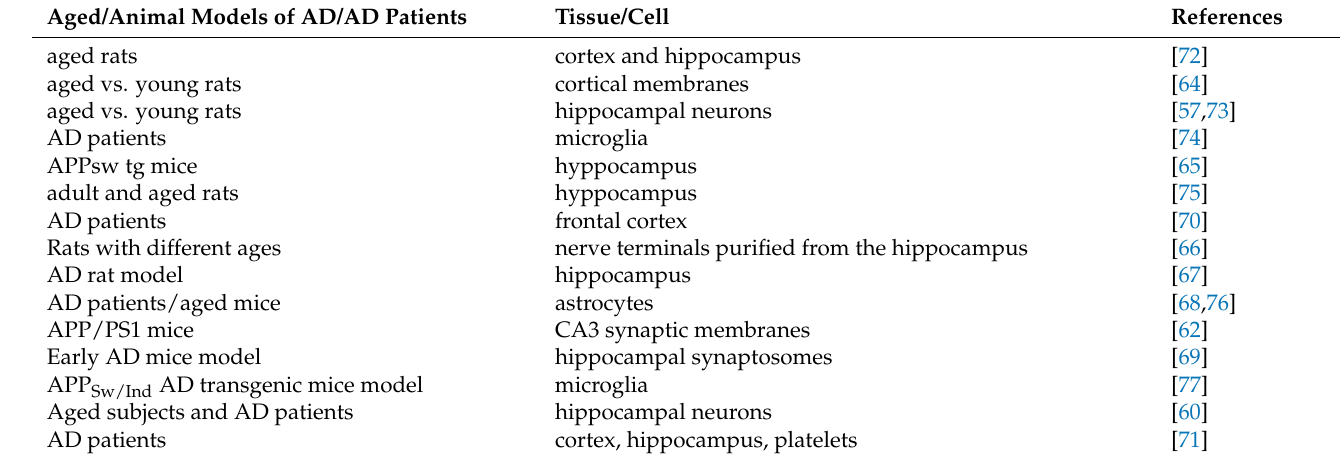
cortex, hippocampus,